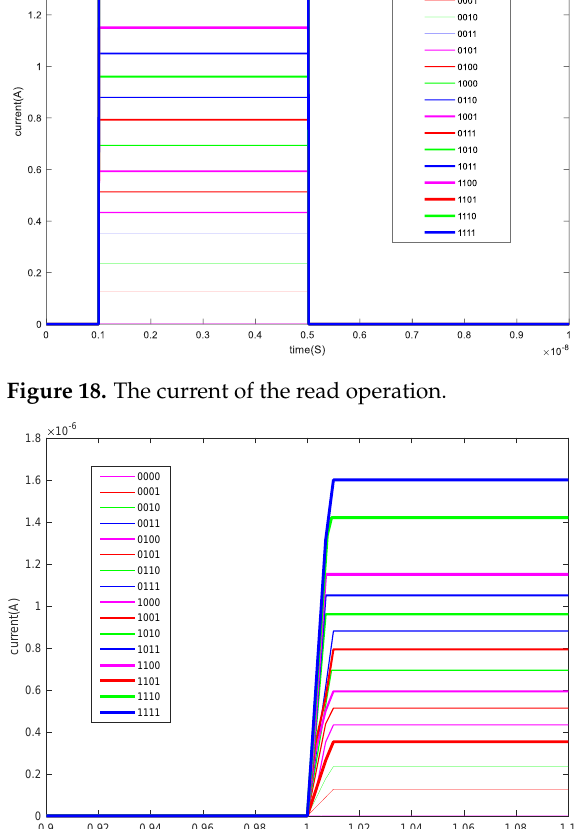
Figure 19. The time delay of the read operation.